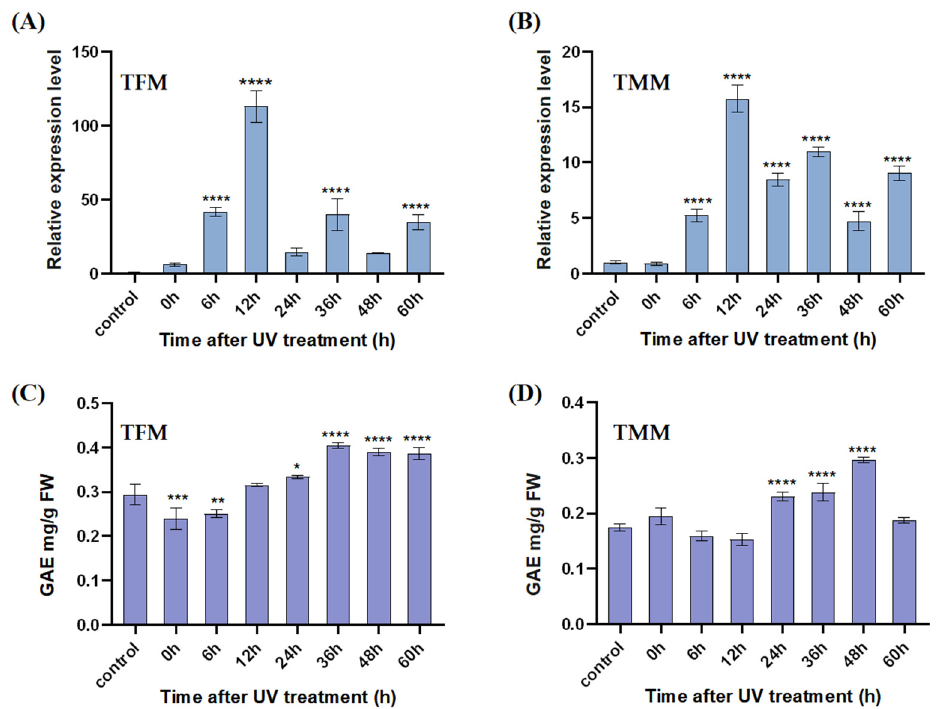
Figure 5. Expression patterns of MpSTCS1A in the female ( A ) and male ( B ) thallus of M. polymorpha and total phenolic acid content in the female ( C ) and male ( D ) thallus of M. polymorpha response to UV-B stress. The results are shown as the means of three replications with the standard deviations. Analysis of variance (ANOVA) and multiple range test (Tukey’s test) indicated significant differences. * p < 0.05, ** p < 0.01, *** p < 0.001, **** p < 0.0001. The total phenolic acid content in the extract was measured by the standard curve (y = 0.0483 x + 0.0169, R 2 = 0.9981).